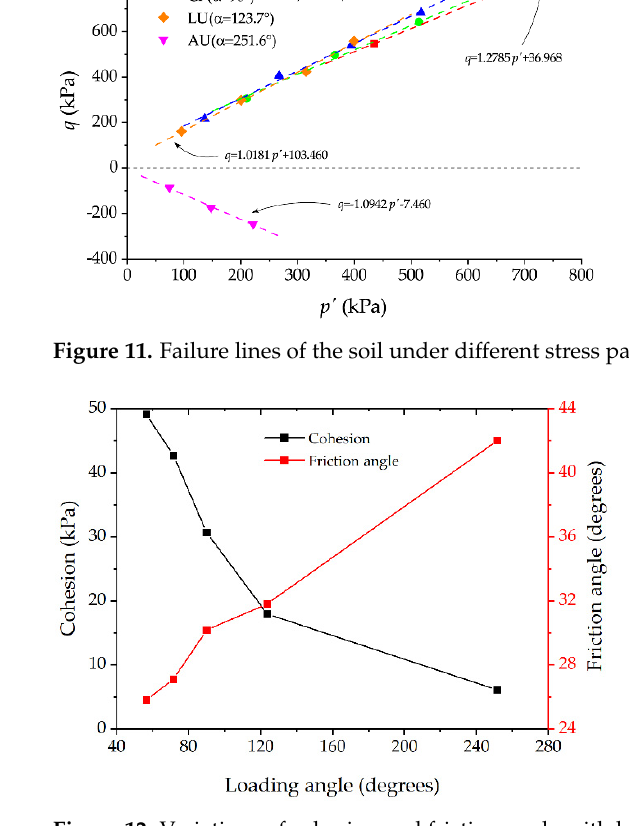
Figure 12. Variations of cohesion and friction angle with loading angle.